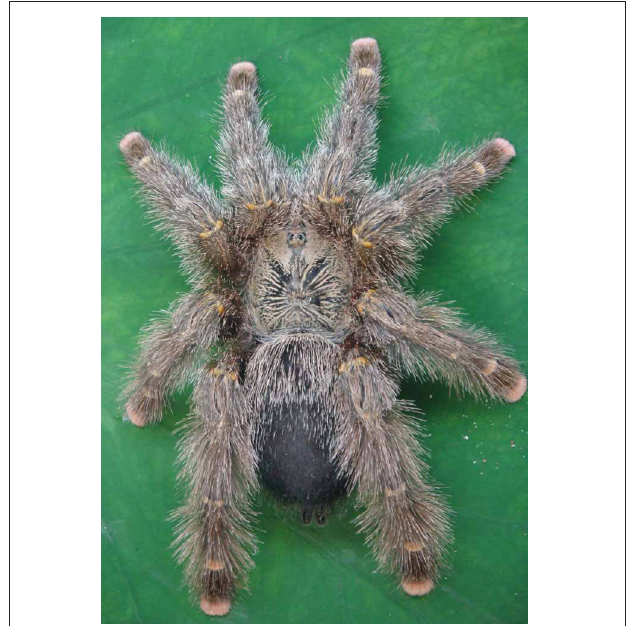
FIGURE 1 | Adult female Avicularia juruensis (Theraphosidae, Mygalomorphae). Photo: Ayroza,